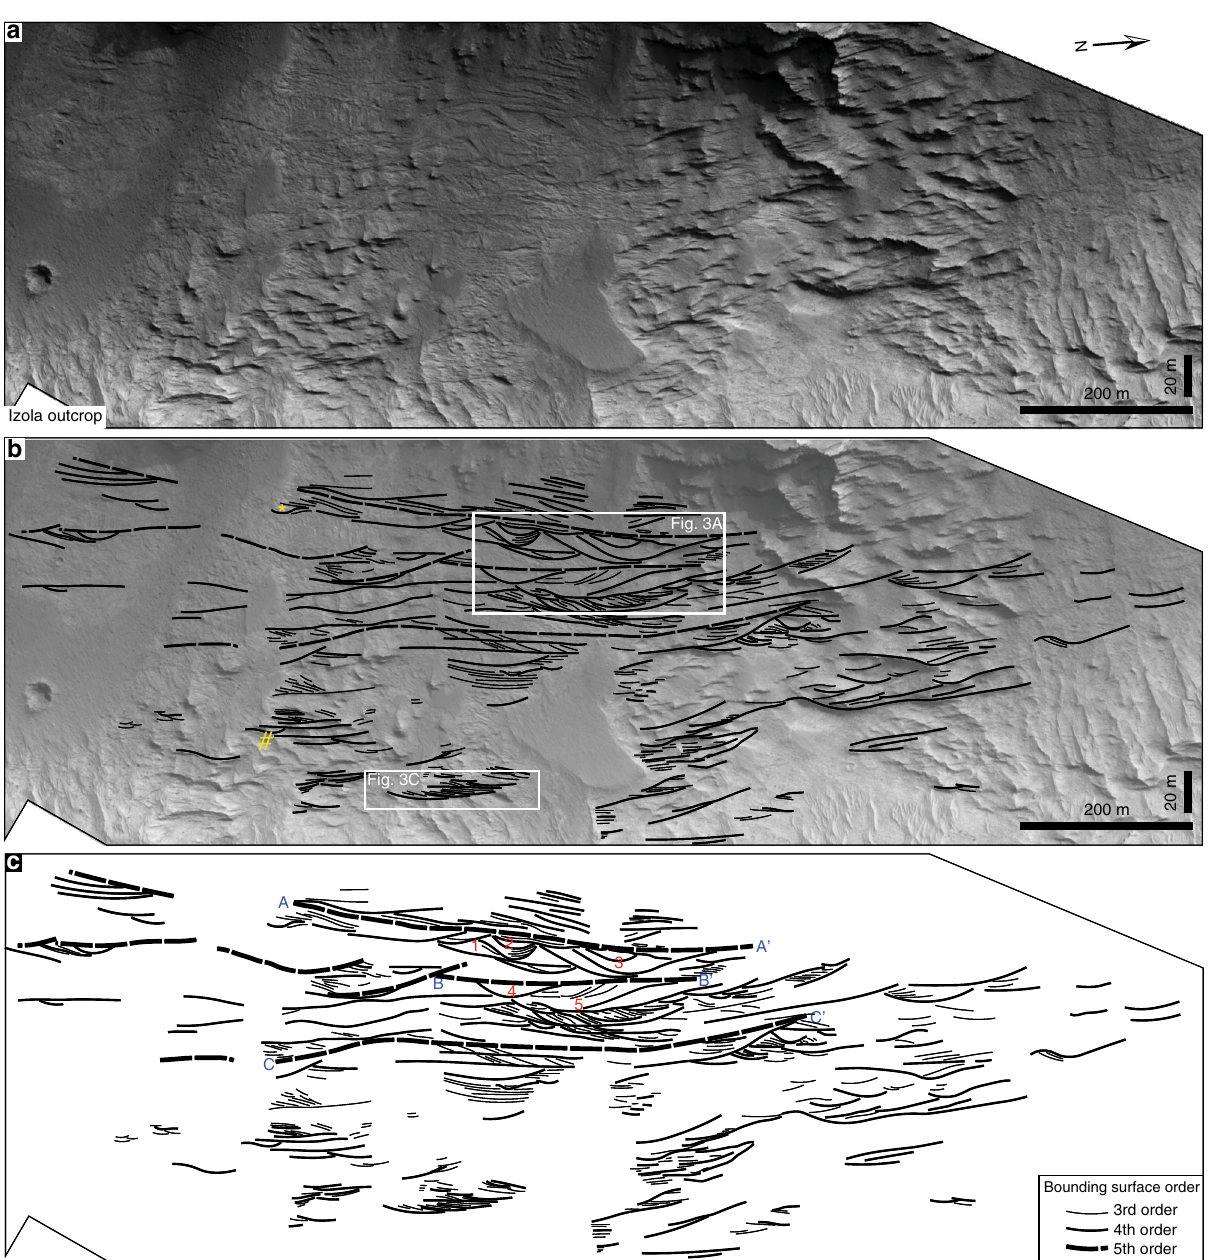
Fig. 2 Architectural analysis of Martian channel forms and inclined accretionary surfaces at the Izola outcrop. a High-resolution imaging science experiment (HiRISE) image of the studied outcrop (ESP_055357_1540; 25 cm/pixel resolution). Objects down to 77 cm can be resolved. The outcrop is 1500-m-wide and 190-m-thick. Note the different scale between the vertical and horizontal axis (vertically exaggerated). b Line drawing of a to illustrate an architectural interpretation, displayed in c . Line drawings were only attempted in areas where stratigraphy was clearly visible (no lines were joined across areas on non-exposure). The yellow asterisk and hashtag link to Supplementary Figs. S3 and S4, both possible examples of channel wings. Identi fi ed fi fth- order surfaces are labelled with letters and surface dimensions listed in Table 2. The well-exposed channels are labelled with numbers and their parameters reported in Table